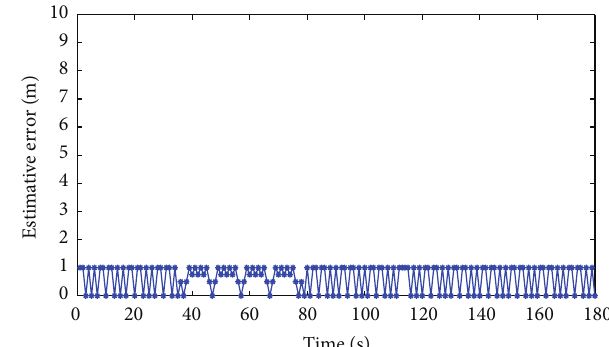
Figure 8: The estimation error result with optimal sensing radius for path 1